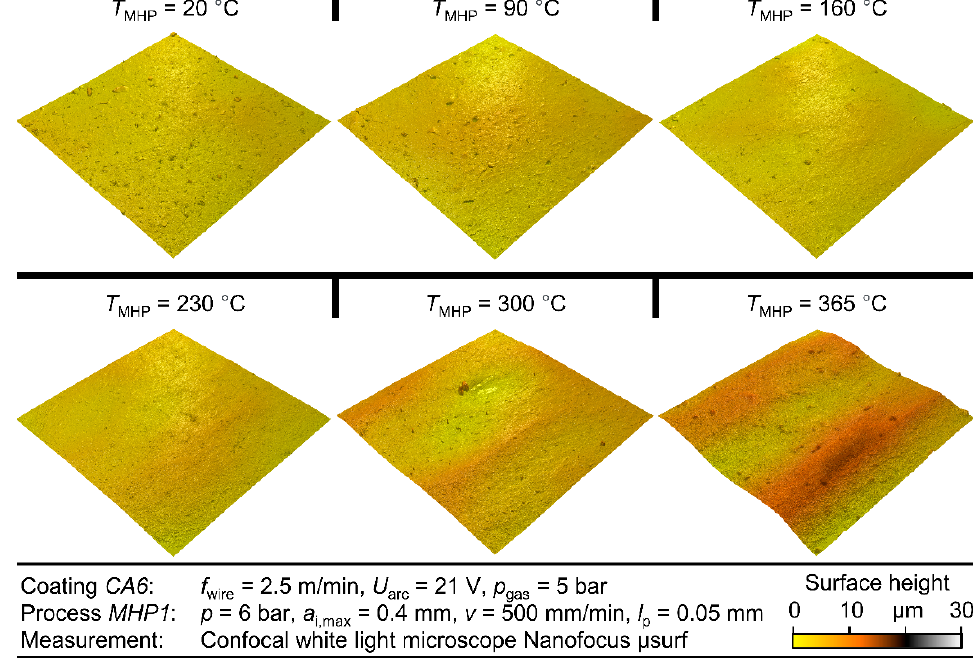
Figure 5. Confocal white light microscopic images of the coating surfaces after TaMHP at tempera- tures between T MHP = 20 °C and T MHP = 365 °C.